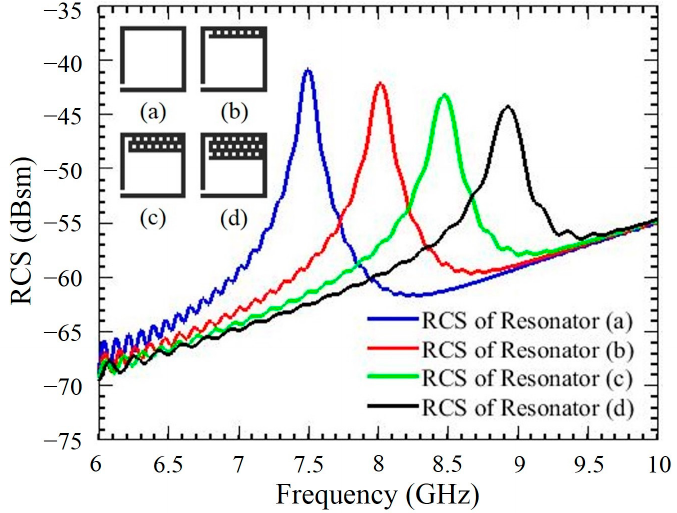
Figure 3. Modeling of open-loop resonators and their simulated RCS responses at various frequen- cies: ( a ) 7.5 GHz; ( b ) 8 GHz; ( c ) 8.4 GHz; ( d ) 8.9